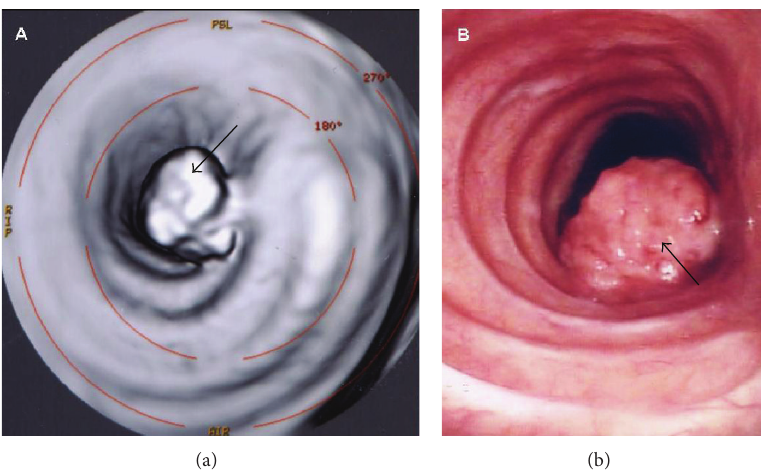
Figure 4: 64-year-old female with granular cell tumor of trachea. (a) Virtual bronchoscopy image (16-slice Multidetector CT, GE Medical Systems) and (b) real bronchoscopy image that shows intratracheal sessile lesion (black arrows), characterized by round shape and polylobulated border, originating from left wall of middle portion of trachea and protruding into trachea lumen occupying half of its diameter.